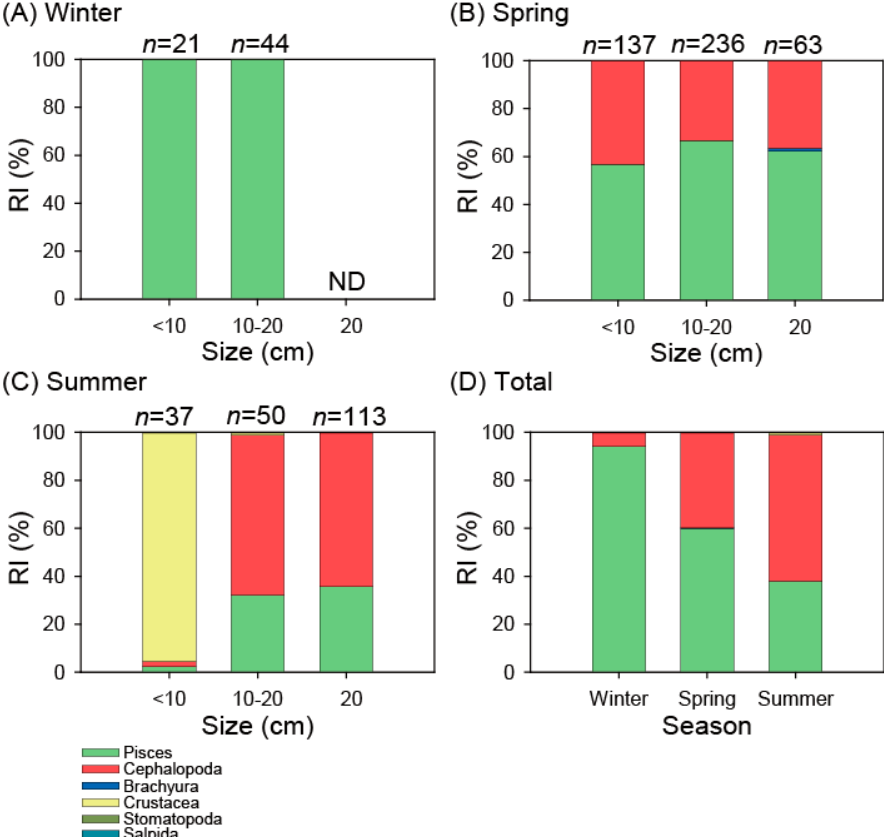
Figure 2. Size-related (mantle length, ML; three size classes, <10 cm, 10–20 cm, and >20 cm) and total ( D ) compositions of the stomach contents of common squid Todarodes pacificus based on the ranking index (%RI) expressed as a percentage of the sum of the RI values in the South Sea of Korea during February (winter, ( A )), May (spring, ( B )), and August (summer, ( C )) 2021. The arrangement of T . pacificus and its dietary items based on DCA ordination yielded eigenvalues of λ 1 = 0.928, λ 2 = 0.221, and λ 3 = 0.138 for the first composition